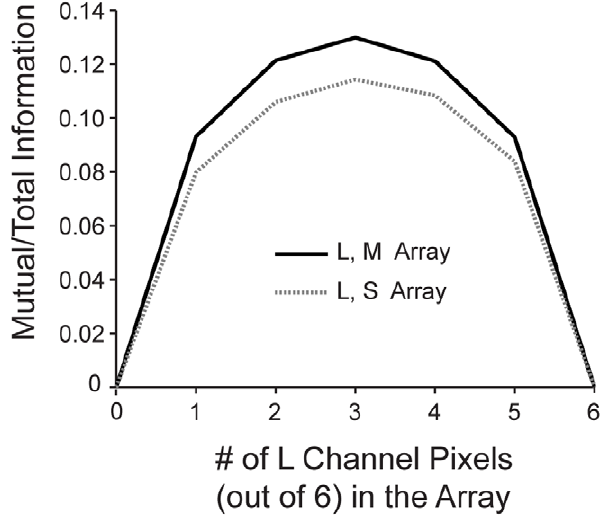
Figure 3. Mutual information between cone arrays. Mutual information between L pixels and M pixels (solid line) and between L pixels and S pixels (dotted line) is shown as a function of the number of L pixels (out of 6) in the array.